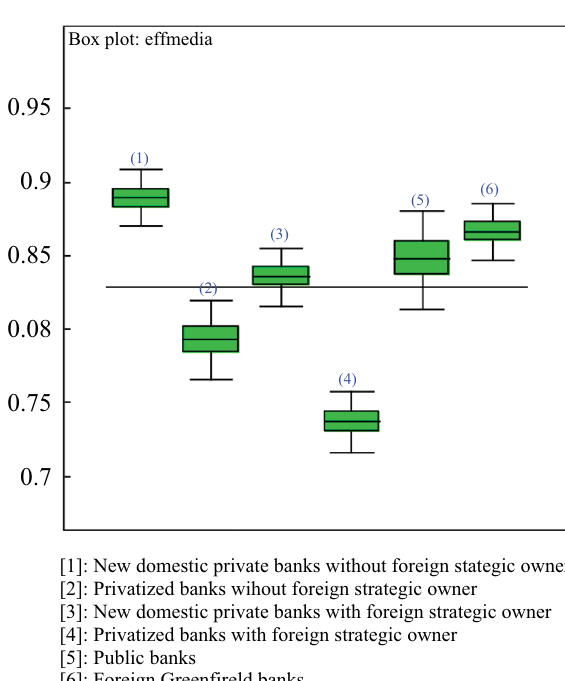
Fig. 4. Boxplot of the posterior distribution of the mean profit bank efficiency classified according to its type of ownership distinguishing the presence/absence of a foreign strategic owner and using the truncated normal